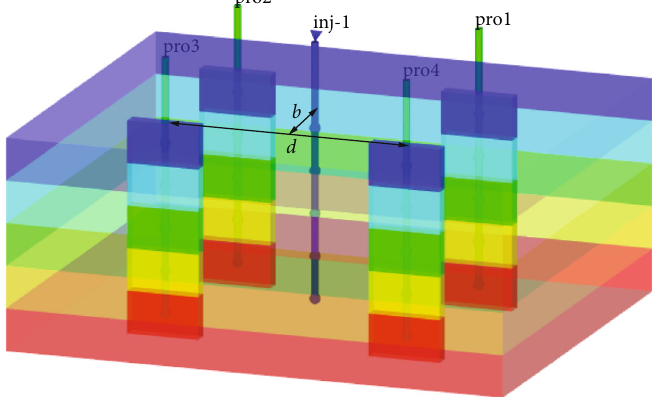
Figure 3: Three-dimensional reservoir model of inverted 5-spot well pattern.